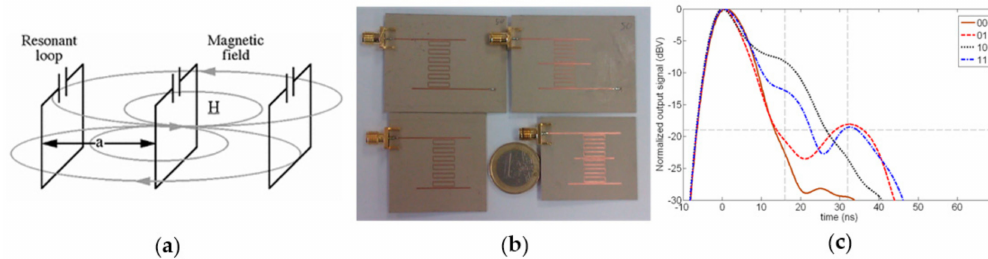
Figure 6. ( a ) Magneto inductive waveguide which consists of a set of capacitively loaded loops, magnetically coupled to each other. Figure extracted from [30]; ( b ) photograph of the fabricated set of 2-bit chipless RFID tags proposed by Herraiz et al. and ( c ) measured response. Figure extracted from [26].